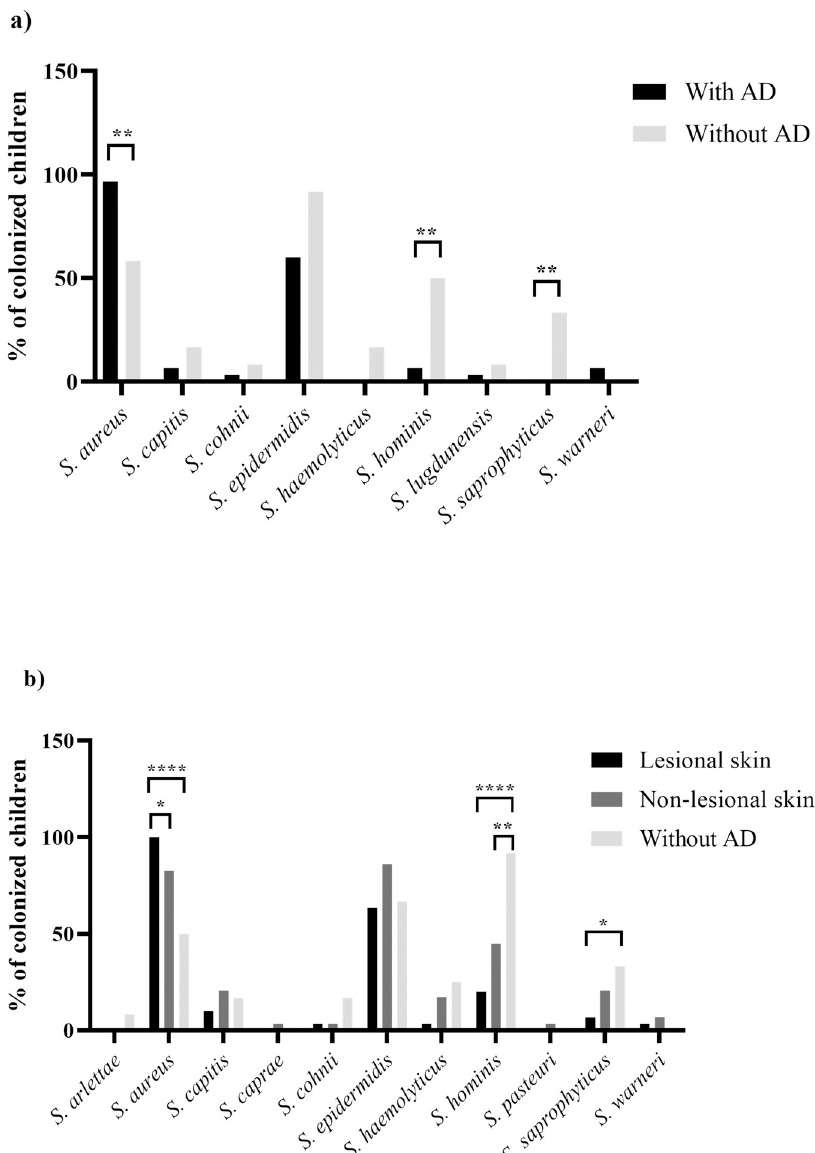
Fig 2. Skin and nasal colonization by Staphylococcus spp. in 30 children with atopic dermatitis and 12 without the disease. a) Skin colonization; b) Nasal colonization. AD- Atopic dermatitis. Collection of a non-lesional skin swab was not performed on a child in the atopic dermatitis group, and therefore the calculation of the percentage of this isolation site was performed for 29 children. The symbols � , �� , and ���� indicate, respectively: P < 0.05, P < 0.01, and P <